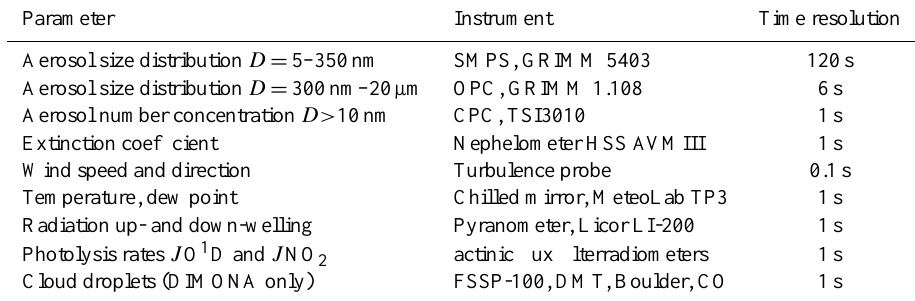
Table 1. Aircraft instrumentation. Parameter